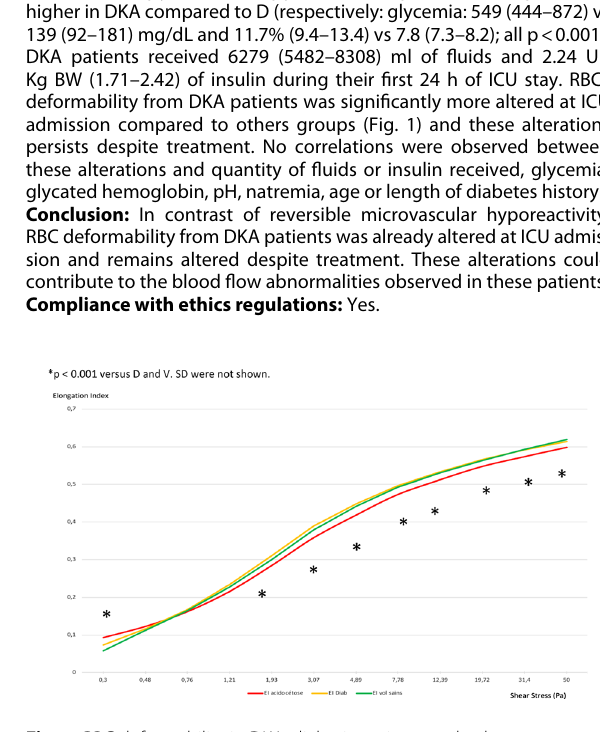
Fig. 1 RBC deformability in DKA, diabetic patients and volunteers. *p < 0.001 versus D and V. SD were not